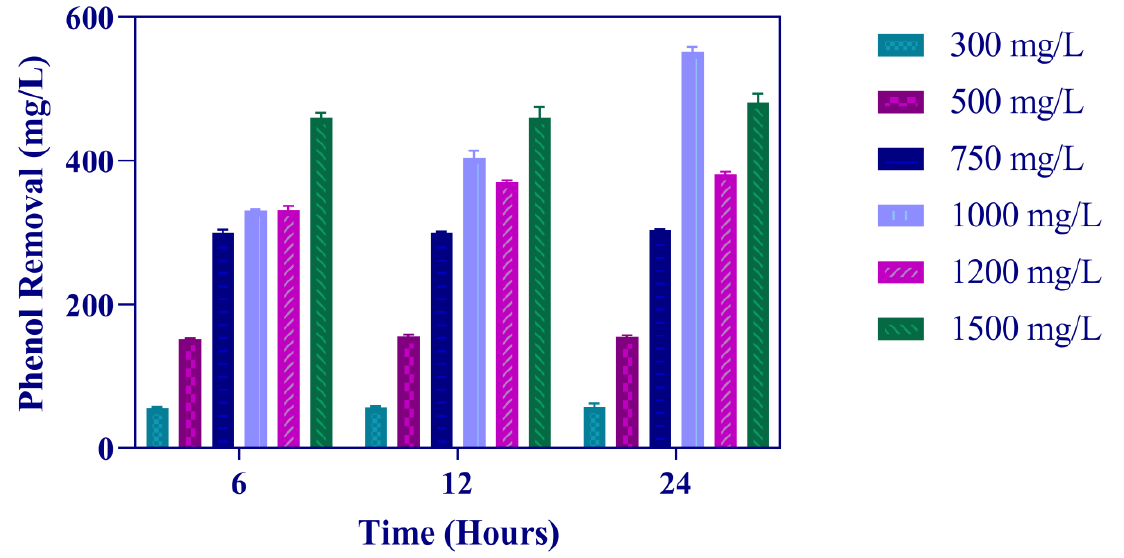
Figure 2. Phenol removal by Sphe3 cultivated in the presence of 300 – 1500 mg/L phenol, at 30 °C, after 6, 12, and 24 h. Error bars indicate standard deviation of three measurements.